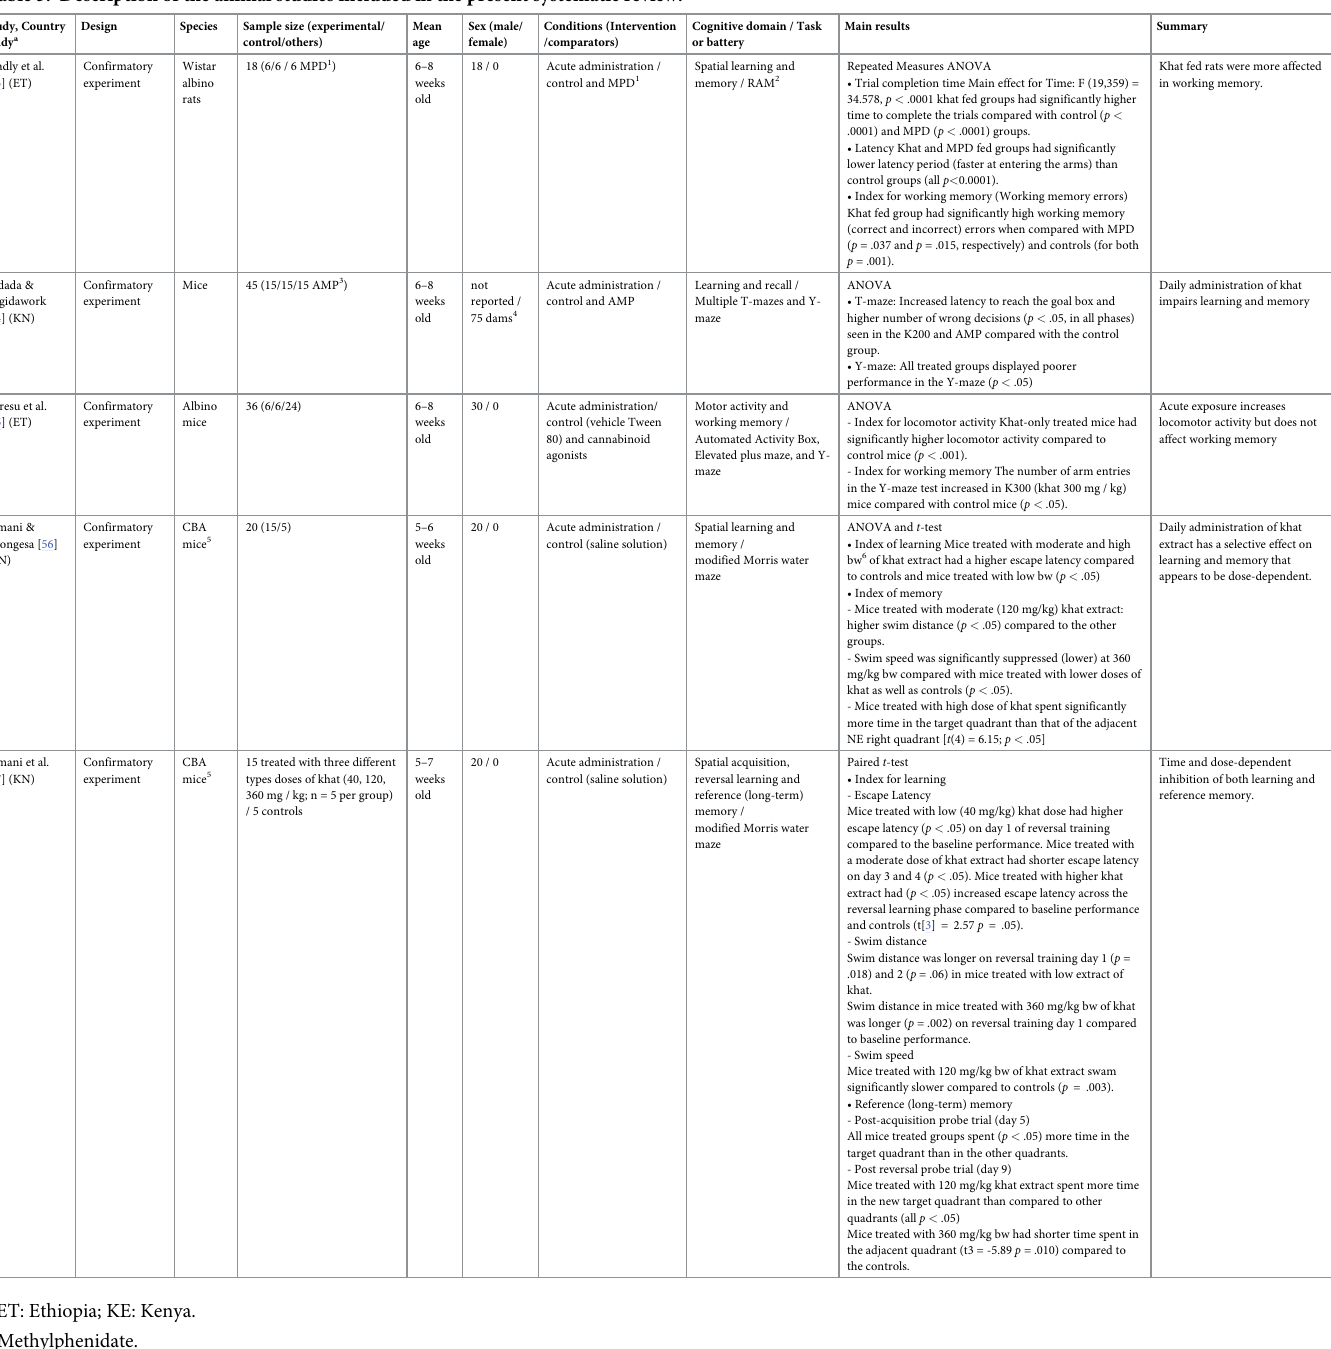
Table 3. Description of the animal studies included in the present systematic review.